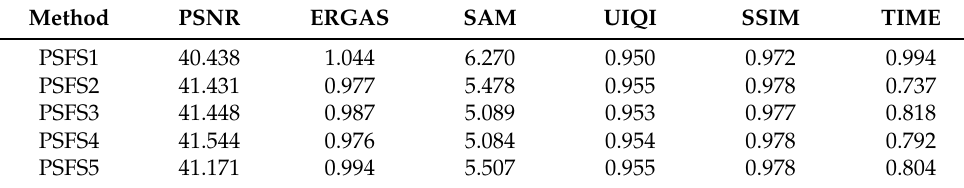
Table 8. The results of the different PSF set in FTMSVD on the CAVE data